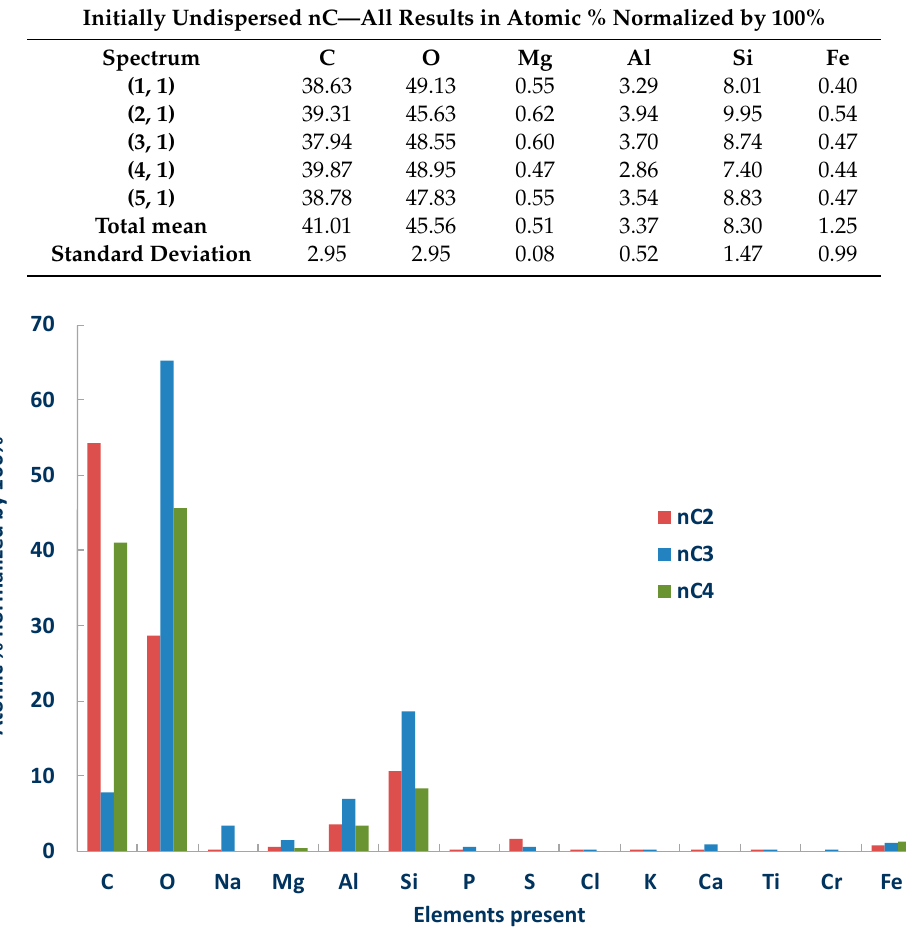
Figure 4. Comparison of the elemental composition of the organomodified nanomontmorillonite (MMT) dispersion (nC2), inorganic MMT dispersion (nC3) [19], and organomodified MMT powder (nC4).